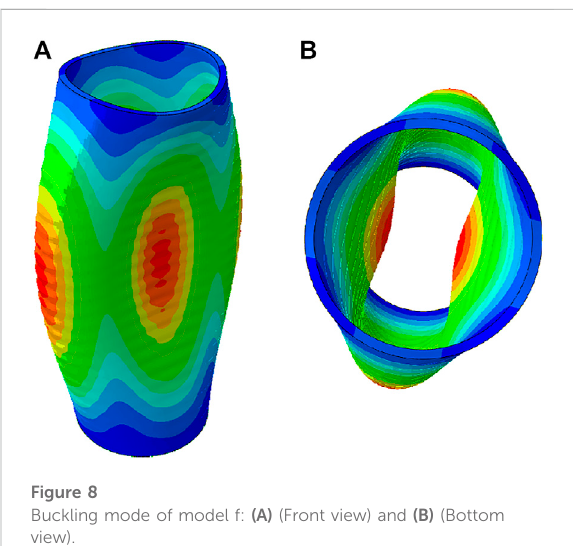
Figure 8 Buckling mode of model f: (A) (Front view) and (B) (Bottom view).